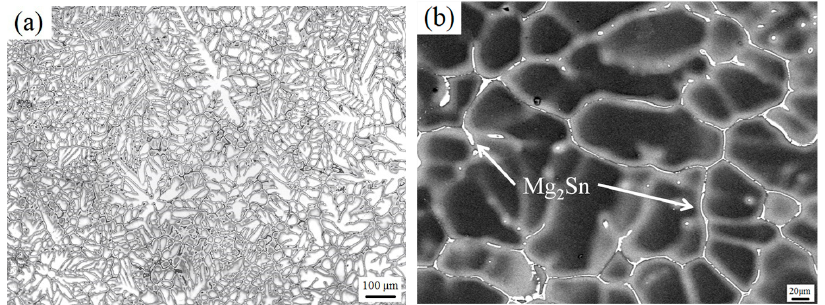
Figure 2. OM and BSE-SEM images of as-cast Mg-6Sn sample: ( a ) OM image and ( b ) BSE-SEM image.